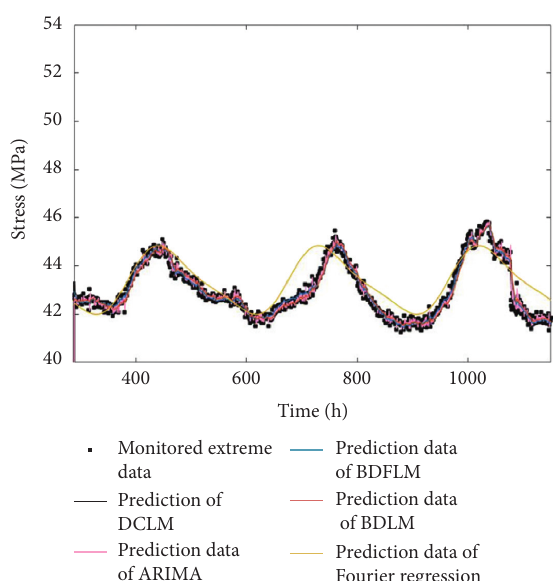
Figure 11: Predicted results of the five